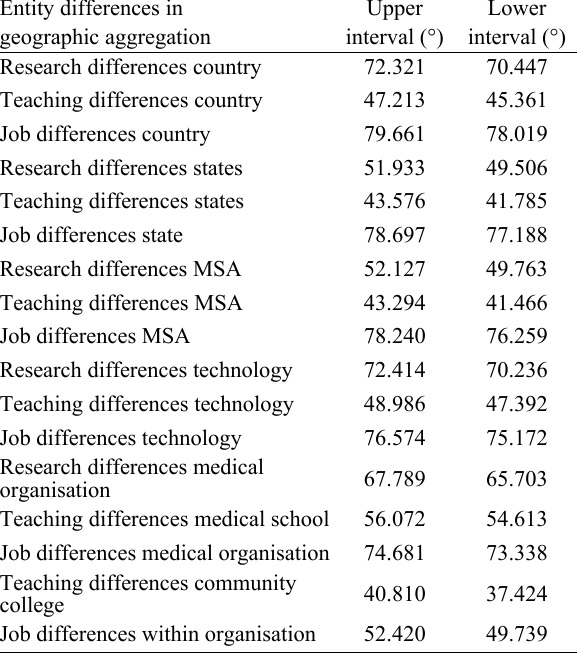
Table 1 Upper and lower intervals of average cosine differences at different regional